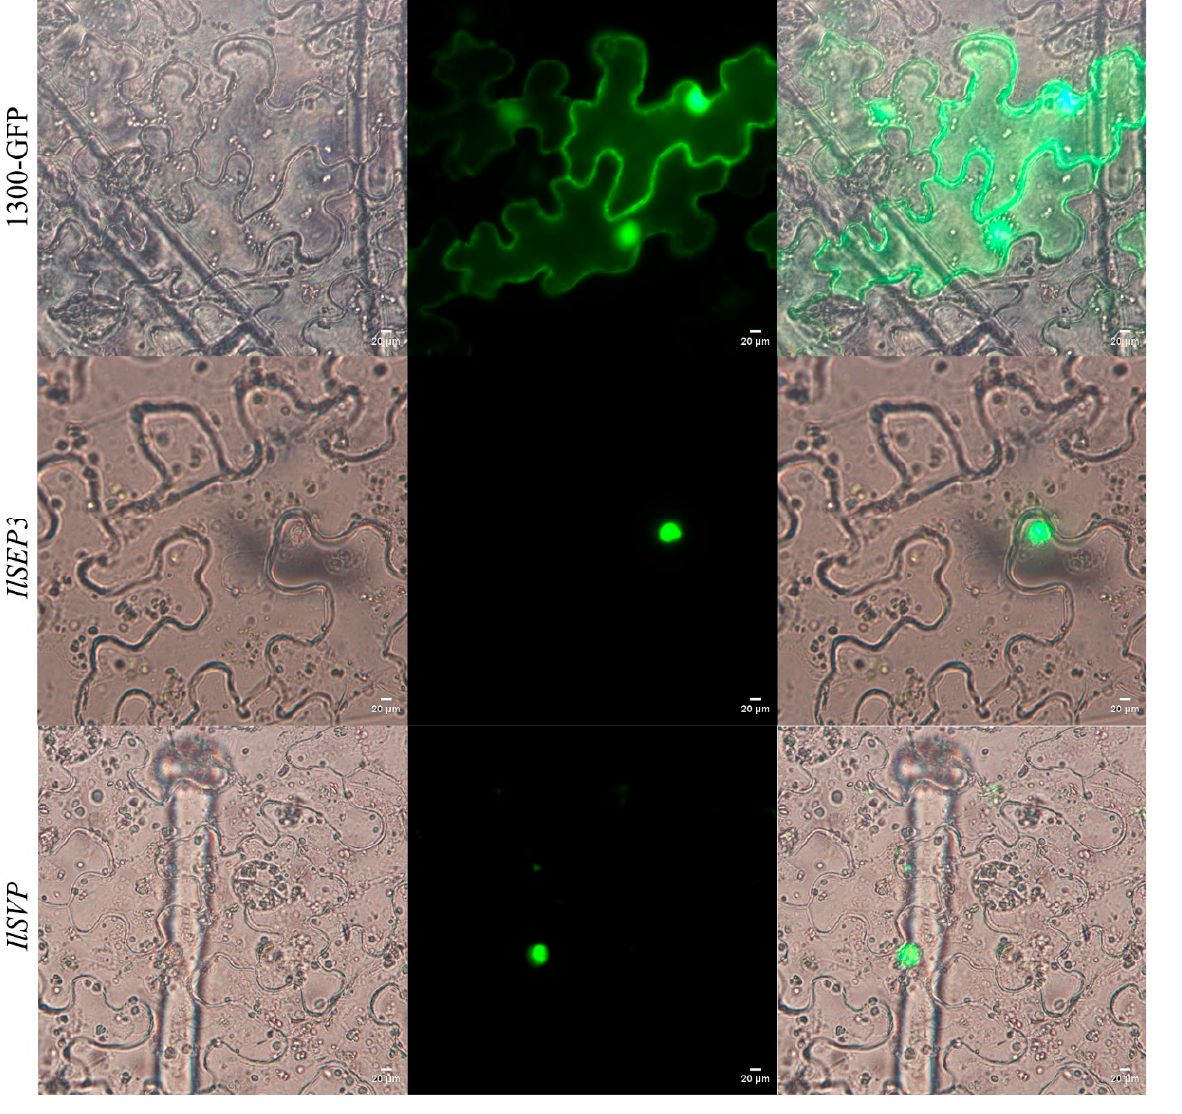
Figure 4. Subcellular localization of Il SEP3 and Il SVP. ( A ) Bright-field; ( B ) GFP; ( C ) merged signals.